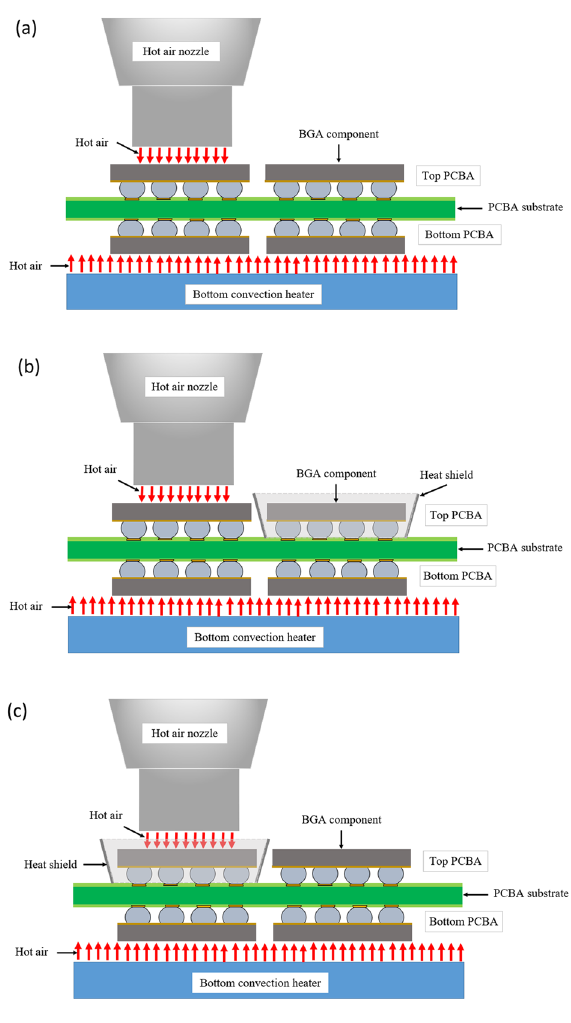
Figure 11. Schematic of BGA component being rework: ( a )—without using the heat shield (sample W); ( b )— with the heat shield on adjacent components of the rework location (sample X); ( c )—with the heat shield on the heat source (sample Y and